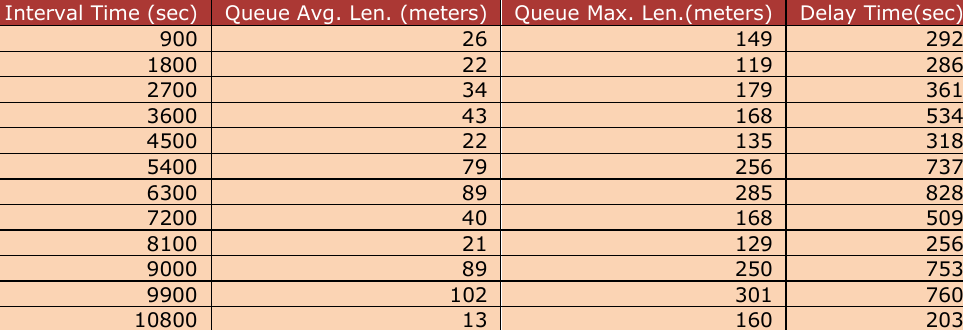
Table 6. Vehicles Queue Statistics at the 1 st Congestion